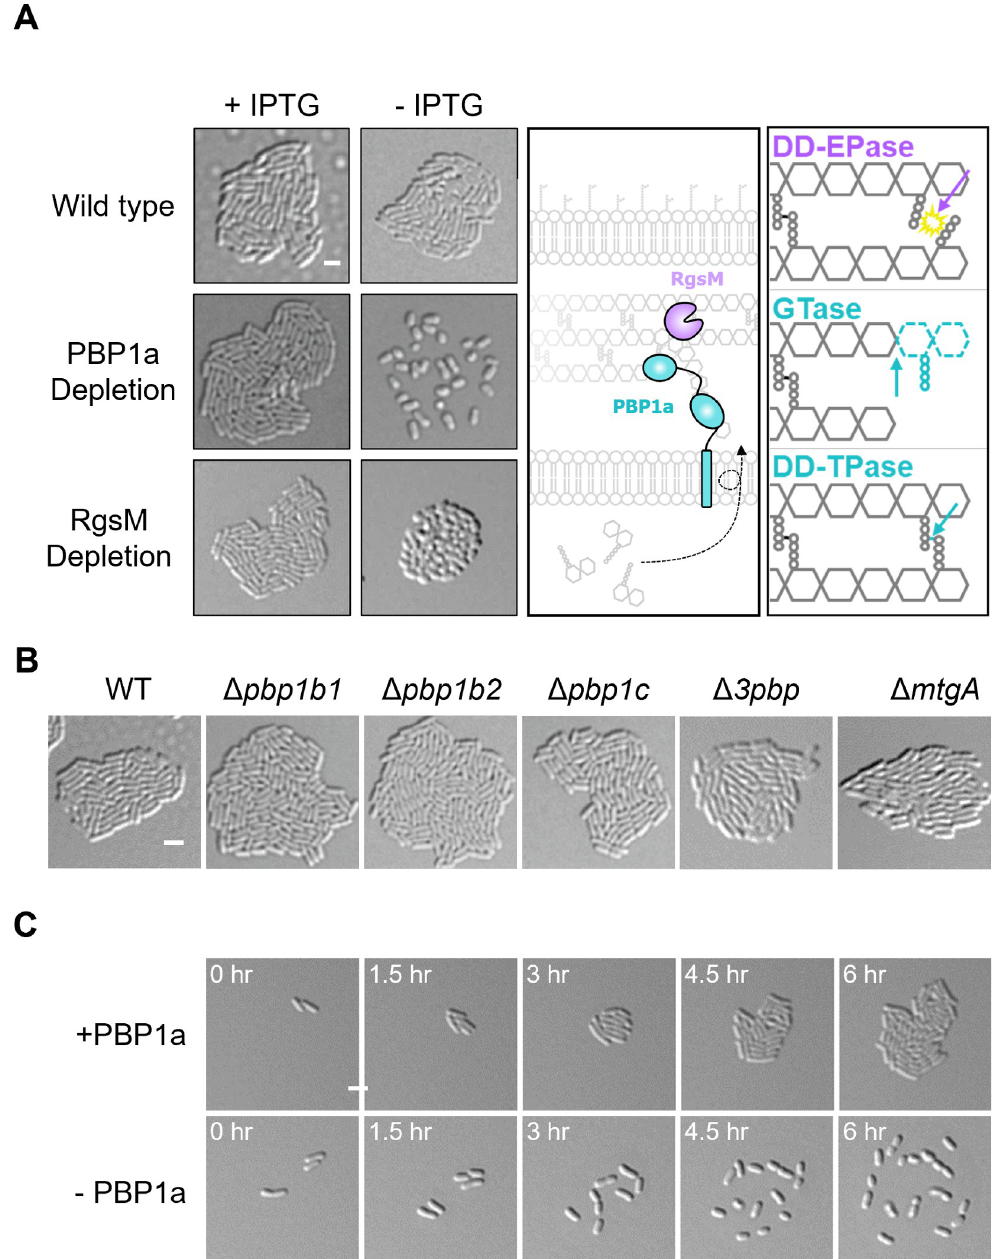
Fig 1. The PBP1a depletion fails to form microcolonies independent of flagellar motility. A. Micrographs of wildtype, PBP1a depletion, and RgsM depletion with or without 1mM IPTG inducer. Each strain was grown to exponential phase, spotted on an ATGN agar pad, allowed to grow for 16 hours, and imaged by DIC microscopy. Scale bar depicts 2 μ m. The graphic depicts the working model that RgsM DD -endopeptidase activity is required for incorporation of nascent glycan strands into the preexisting peptidoglycan (PG) macromolecule by PBP1a. RgsM cleaves DD -crosslinks, PBP1a glycosyltransferase activity incorporates lipid II into the PG glycan strand, PBP1a DD -transpeptidase activity crosslinks the peptide stem of the nascent PG, fully incorporating it into the macromolecule. EPase, endopeptidase; GTase, glycosyltransferase; TPase, transpeptidase. B. Micrographs of wild type, Δ pbp1b1 , Δ pbp1b2 , Δ pbp1c , and Δ mtgA . Each strain was grown to exponential phase, spotted on an ATGN agar pad, allowed to grow for 16 hours, and imaged by DIC microscopy. Scale bar depicts 2 μ m. C. Time-lapse microscopy of the PBP1a depletion grown on an agar pad with or without 1mM IPTG inducer. DIC images were acquired every 10 minutes. Time is shown in hours. For the—PBP1a strain, cells were washed 3X with ATGN media and grown at 28 C with shaking for 4 hours before cells were spotted on an agar pad for